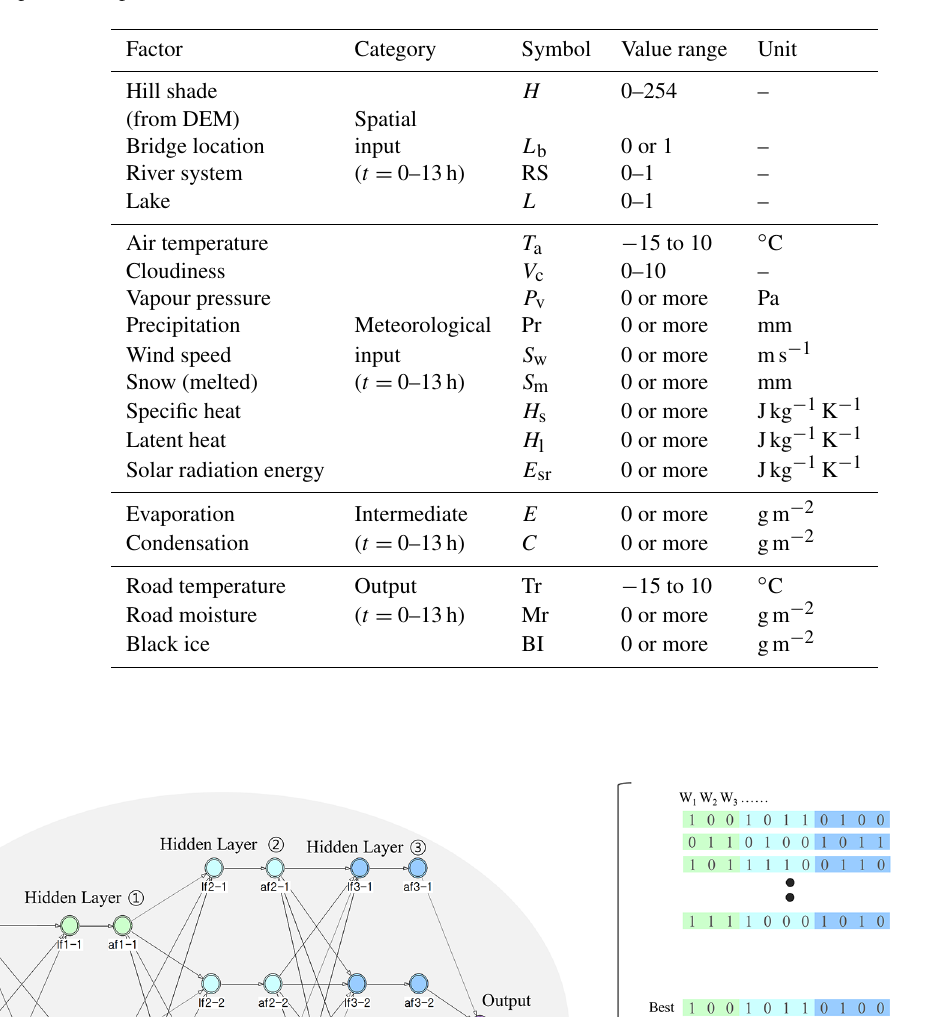
Table 2. Main input and output factors of the model.